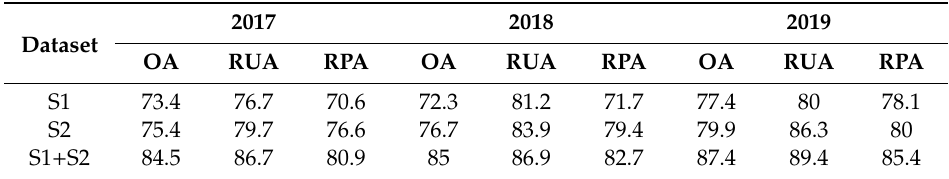
Table 5. Accuracy statistics derived from error matrices of classifications produced with di ff